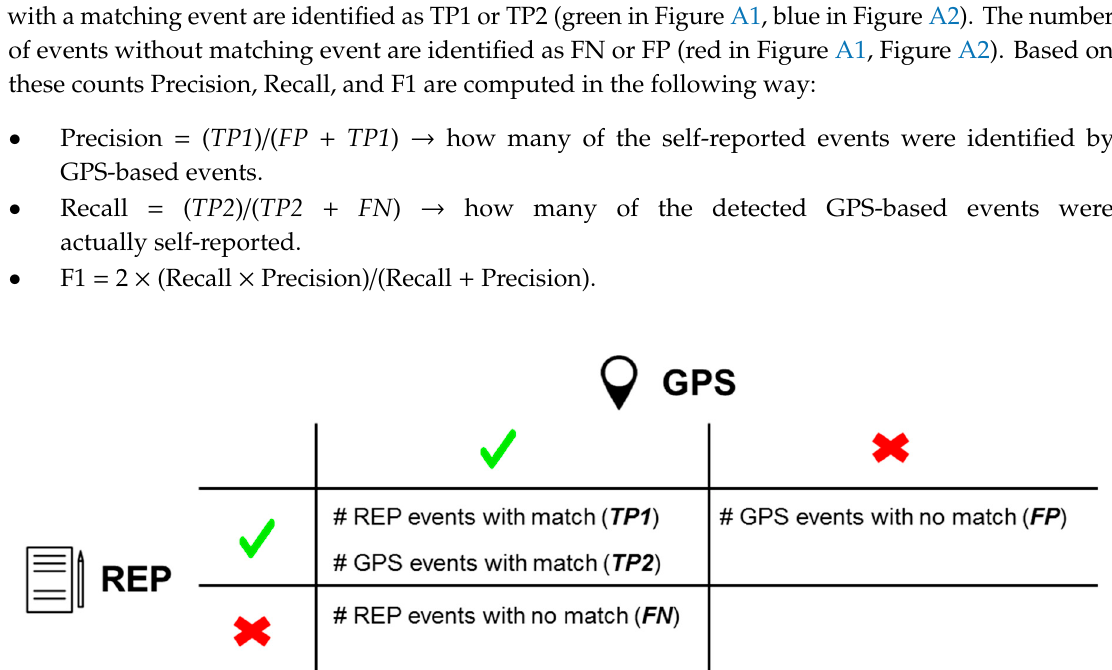
Figure A1. Confusion matrix for data with no ground truth. Note: REP = self-reported, GPS = GPS-based, TP = true positive, FN = false negative, FP = false positive, # =